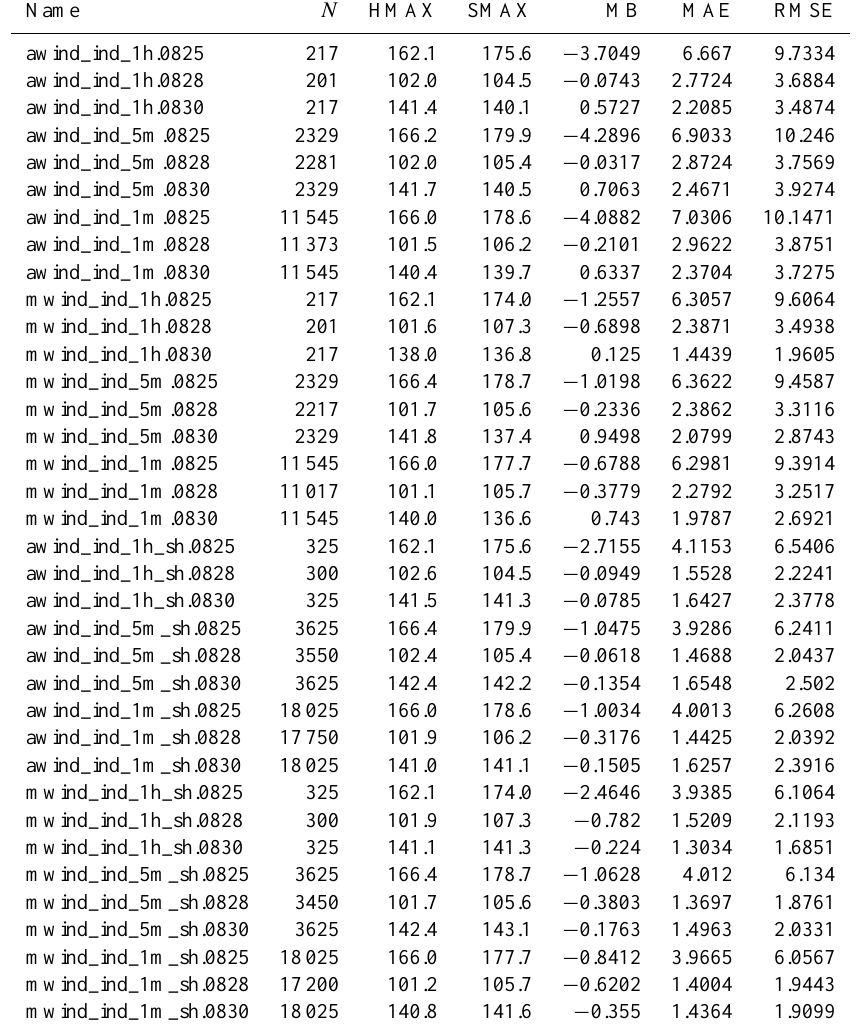
Table 4. Summary of statistical parameters for STOPS–CMAQ concentrations, when STOPS was used in the moving mode, with the starting position in the industrial sub-domain.